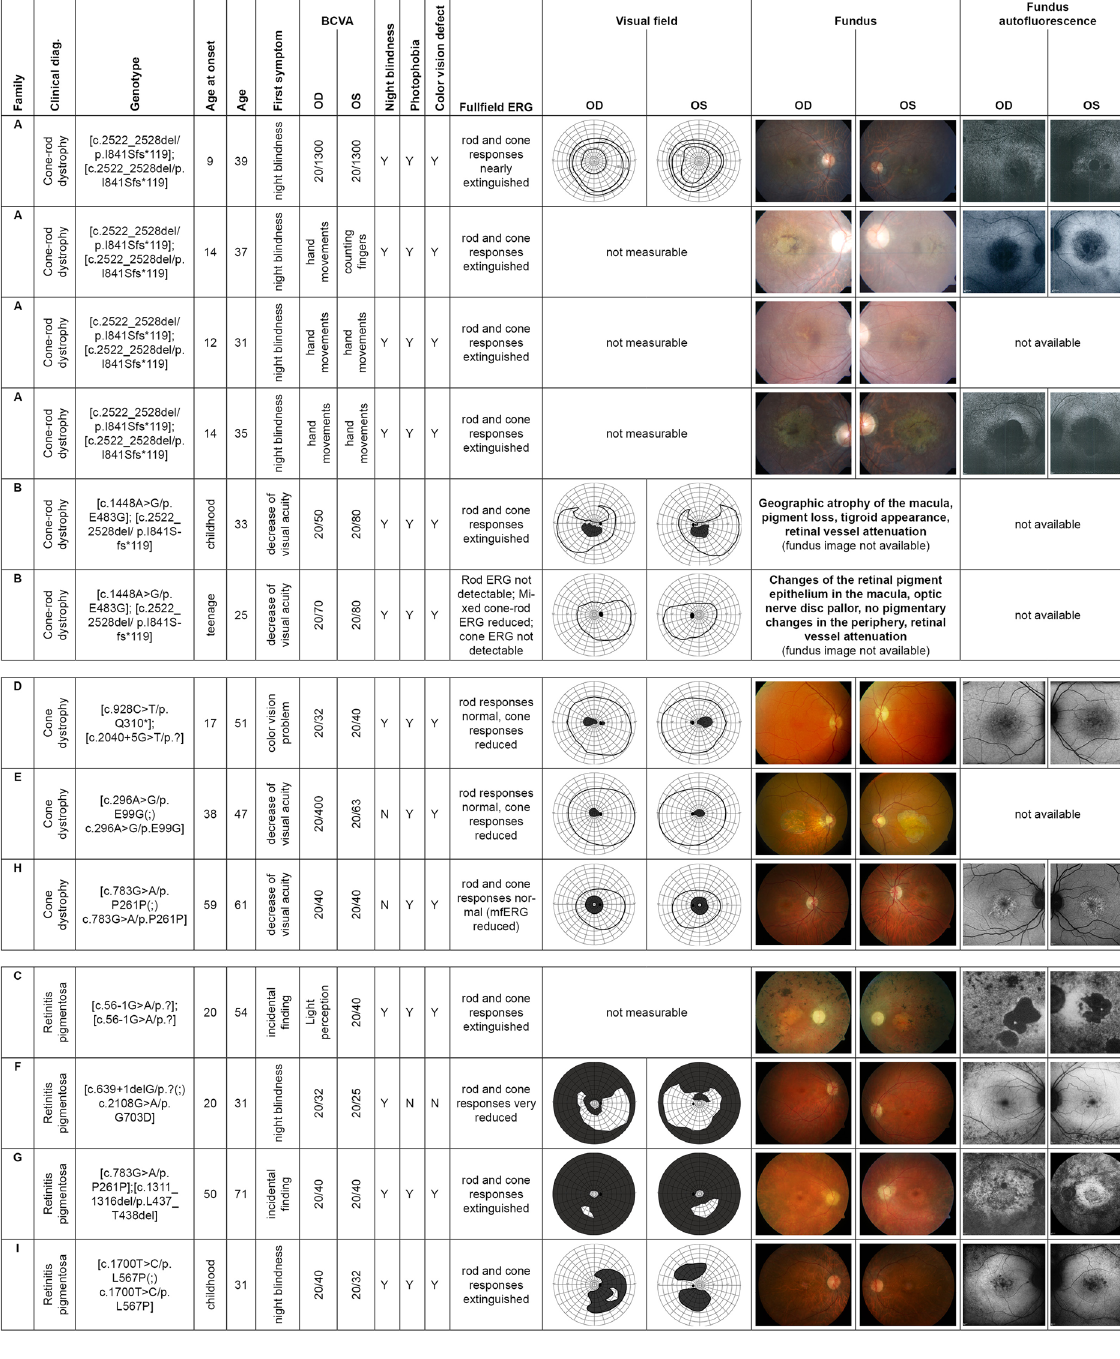
a limited extent. Atrophic macular changes were visible on funduscopy of patients, ranging from geographic atrophy (patient C) or bulls-eye-like changes (patient G) to more subtle changes such as macular pucker (patient I) and an absent foveolar reflex (patient F). In FAF however, changes of the macular/foveal region were visible in all patients. OCT examination showed reduced photoreceptor outer segments up to the fovea in patients F, G and I (the less progressed cases), and rather diffuse outer retinal atrophy in patient C. All patients developed